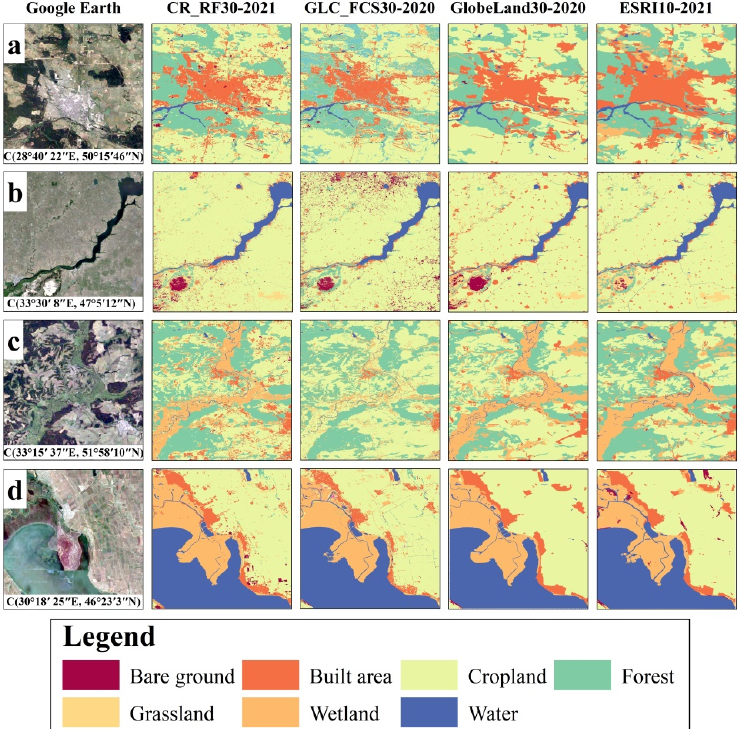
Figure 3. Four representative subsets ( a – d ) for comparing the RF classification results with three land cover products and Google Earth images. The first column shows the Google Earth image, the second column shows the RF classification results named CR_RF30-2021, the following columns illustrate the classification products named GLC_FCS30-2020, GlobeLand30-2020, and ESRI10-2021. C (longitude, latitude) represents the central geographic coordinate of the enlarged